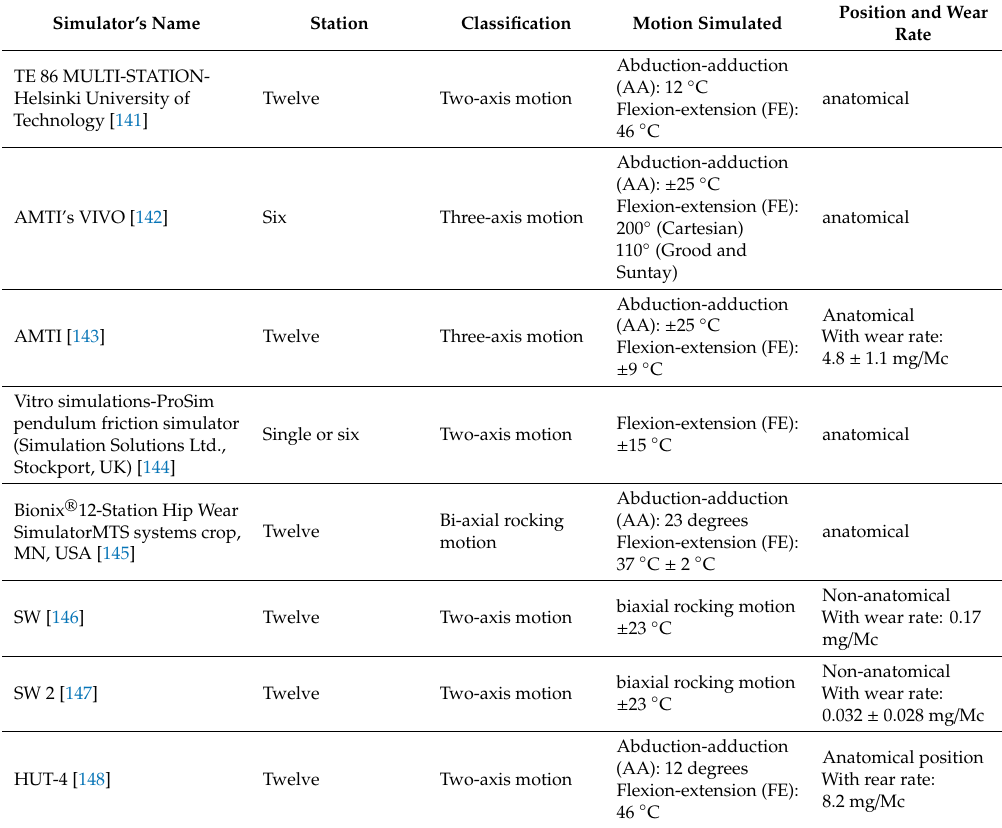
Table 2. Historical hip joint simulator